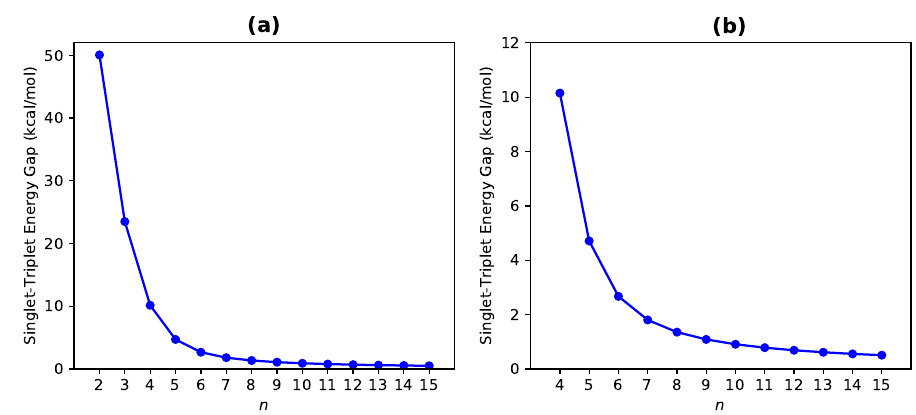
Figure 2. Singlet-triplet energy gap of n -pyrene (( a ) n = 2–15 and ( b ) n = 4–15), calculated by spin-unrestricted